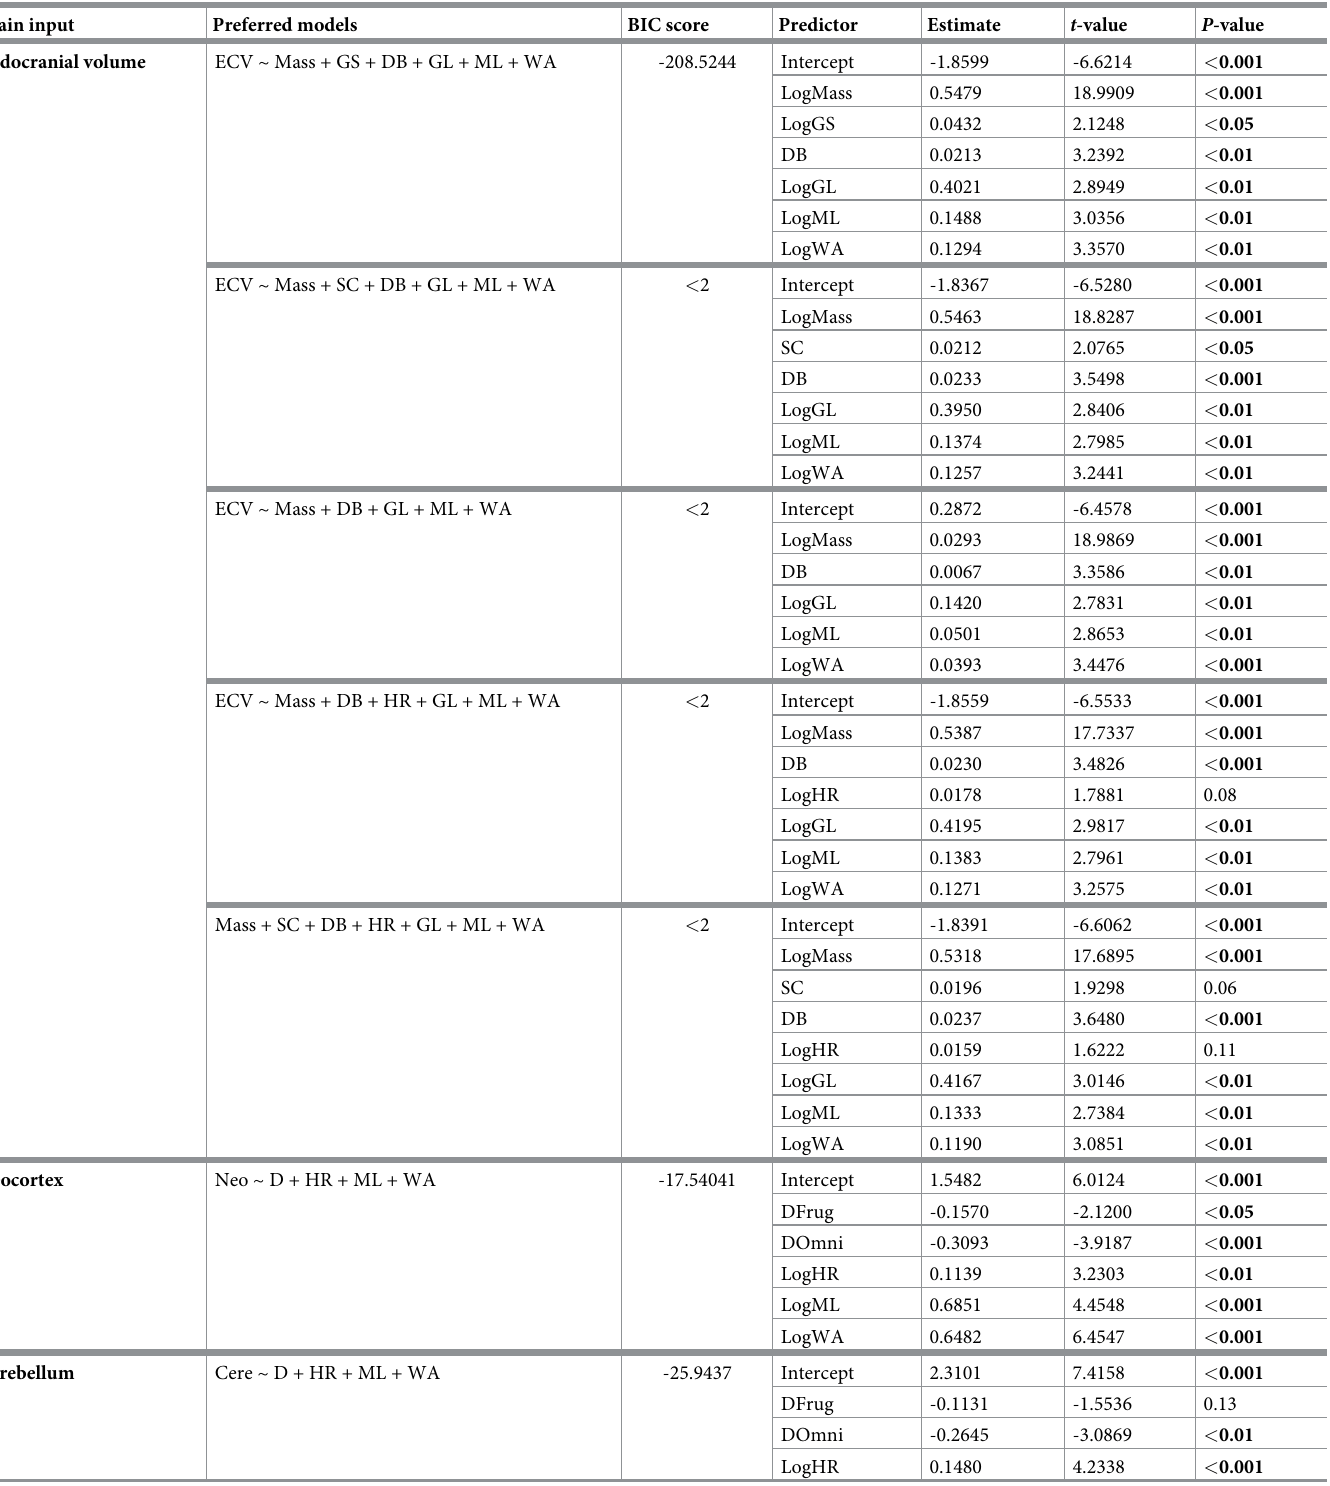
Table 2. Phylogenetic generalised least-squares (PGLS) regression analyses examining the effects of social, ecological and life-history variables � on primate whole and regional brain volumes. Preferred models represent all the ‘ best fit ’ models for each brain input, which in most cases represents a subset of models (any model within dBIC < 2 of the lowest model). This can include any category of model (i.e., social or combined), and is dependent on the BIC score produced. Boldness indicates <